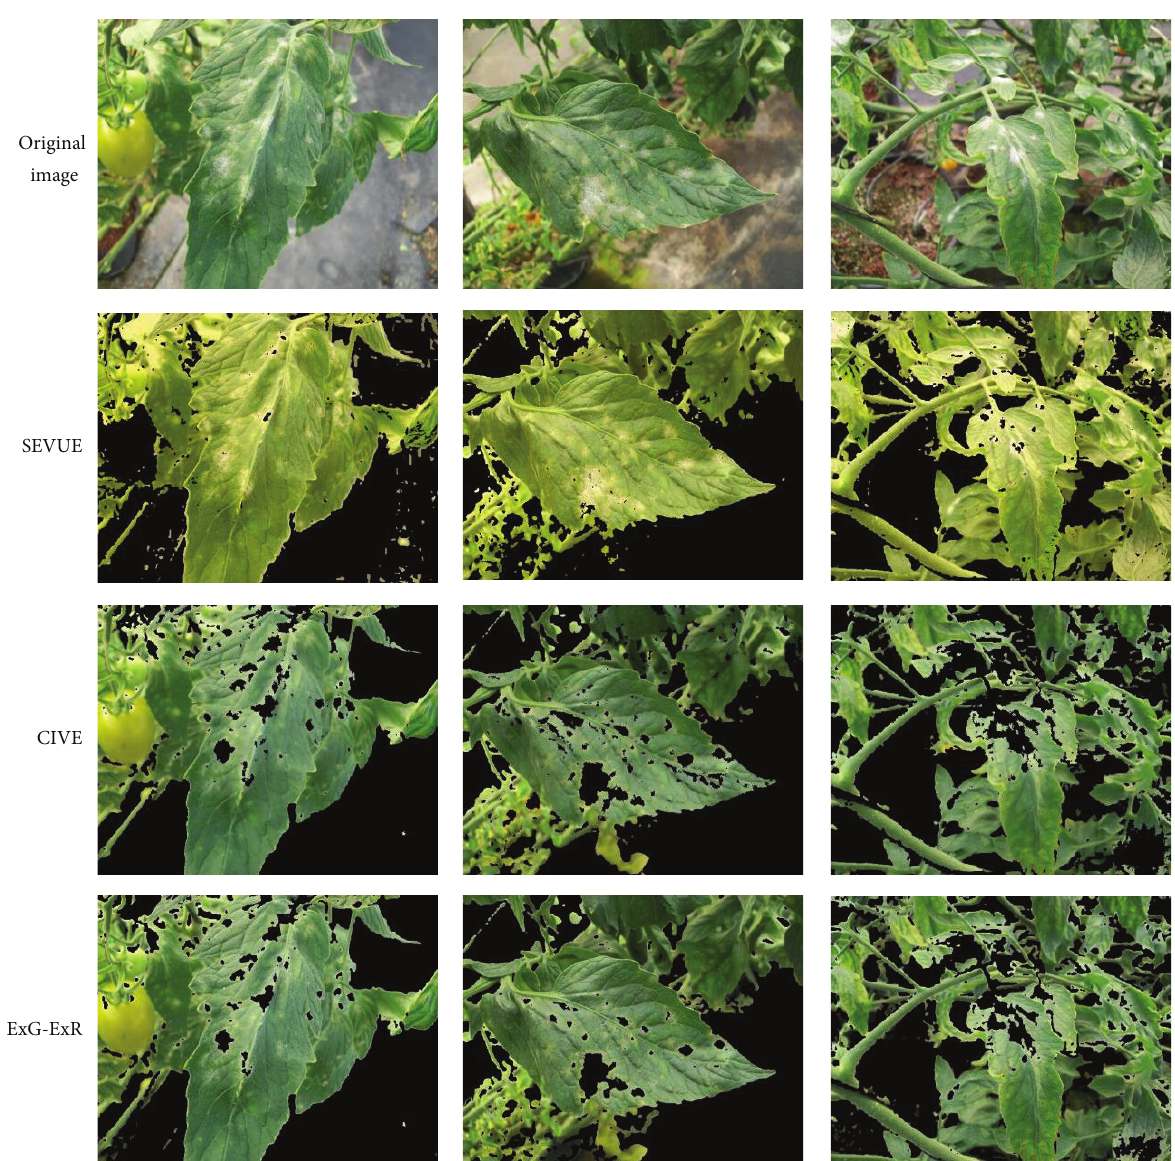
Figure 7: Example results of segmented images by the three methods being